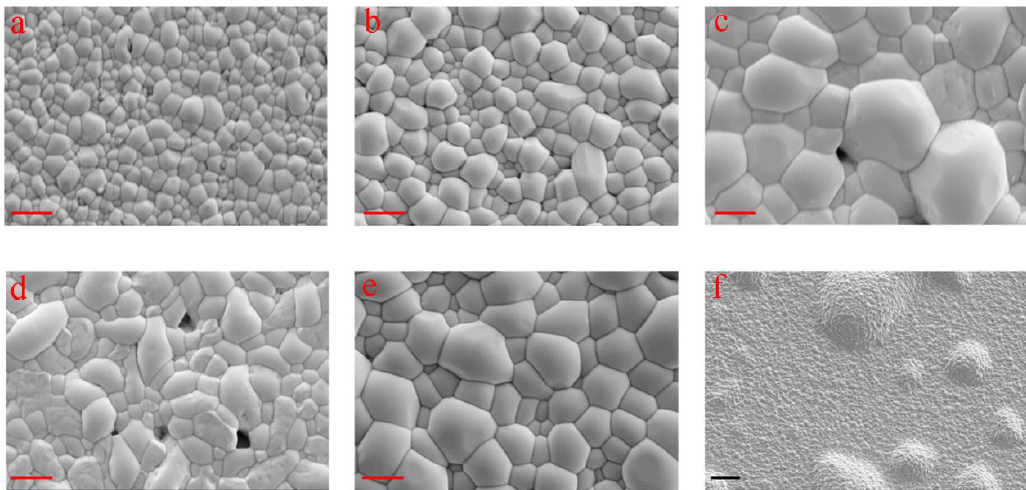
Figure 2. SEM top-view images of crystallized Sb 2 Se 3 thin films sputtered under 2.0 Pa ( a ), 1.5 Pa ( b ), 1.0 Pa ( c ), 0.5 Pa ( d ), mixed pressures ( e ), and 0.1 Pa ( f ). The red scale bars at the left bottom corner of ( a – e ) read 1 µm. The black scale bar at the left bottom corner of ( f ) reads 10 µm.